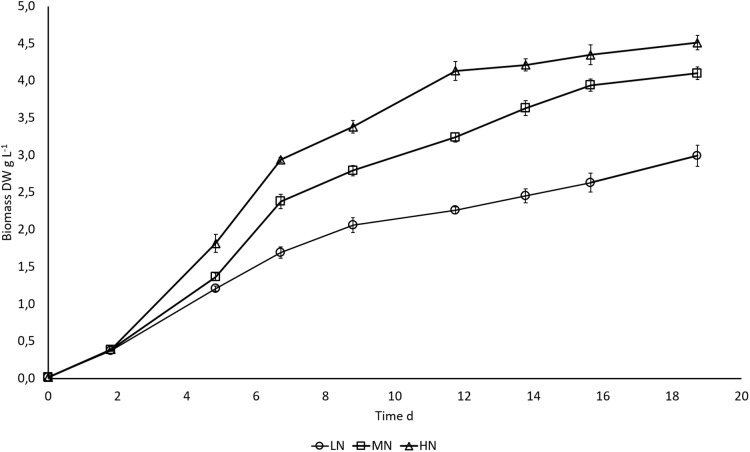
Biomass growth (DW) in  E. gracilis cultures.LN, low N (○); MN, medium N (□); HN, high N (Δ). Mean ± SE, n = 3, error bars are not visible. Differences in biomass DW were statistically significant (P < 0.05) in different N treatments.